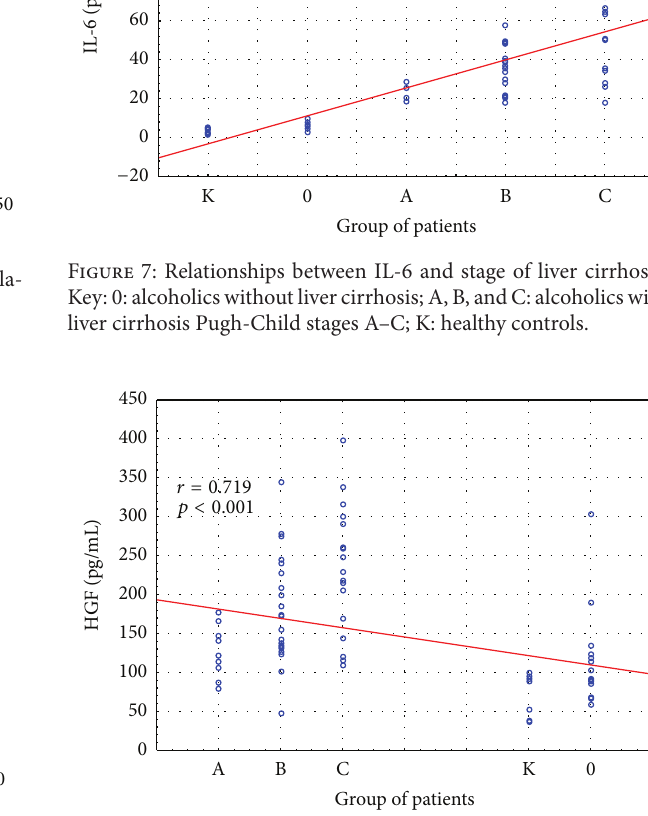
Figure 5: Correlation between HGF and IL-1 𝛼 in the study popula- tion ( 𝑟 = 0.26 ; 𝑝 = 0.048 ).